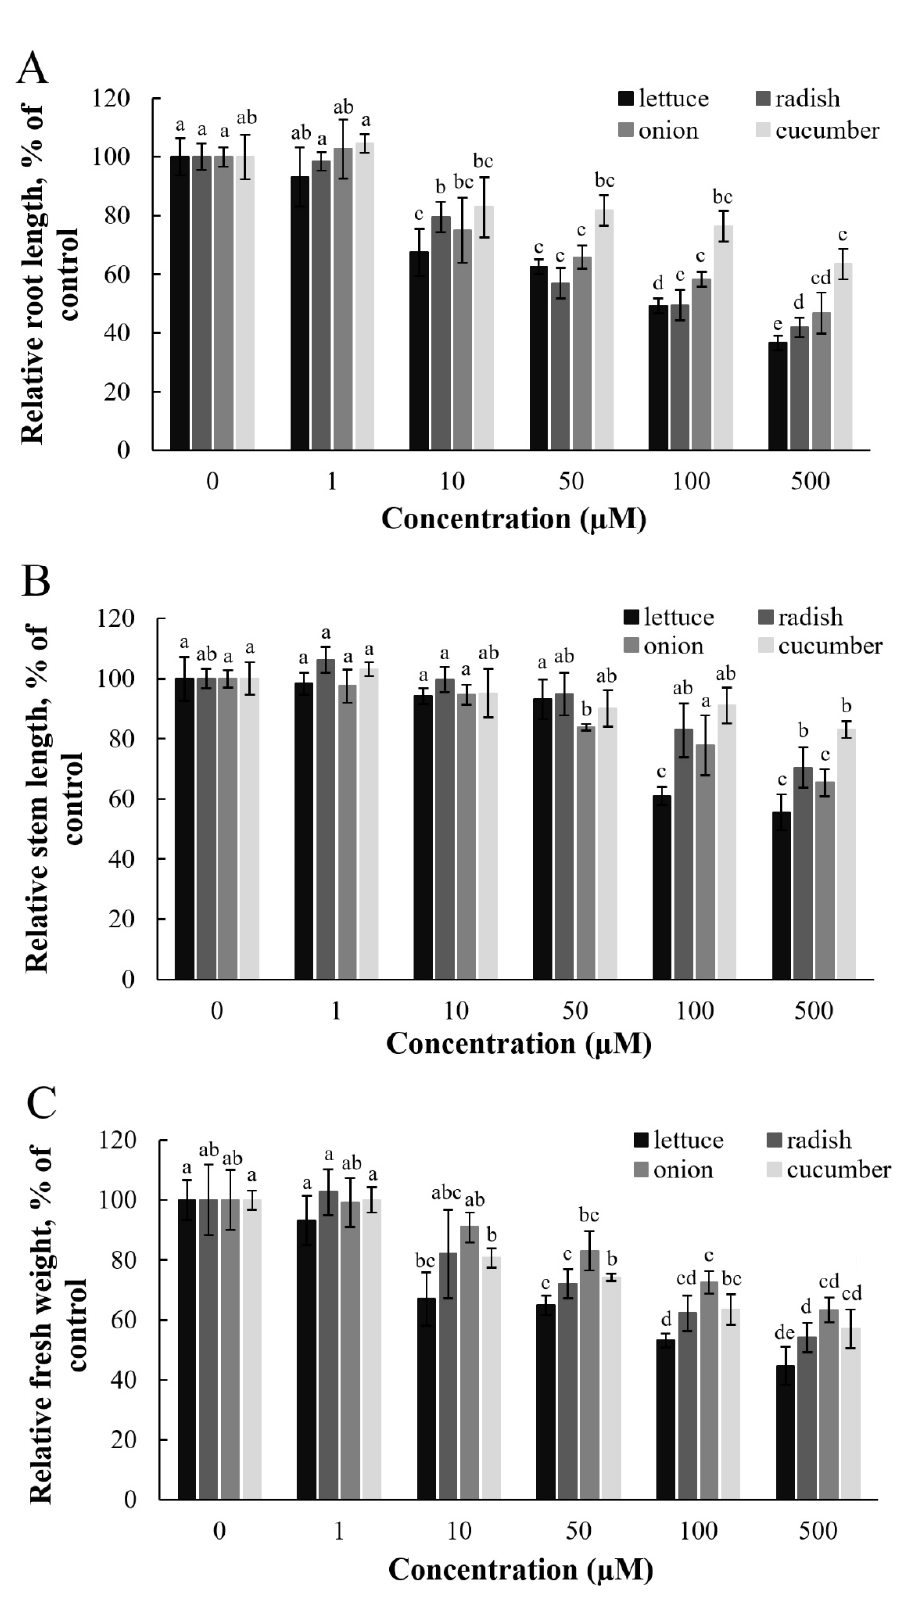
Figure 2. Seedling growth indices of root length ( A ), stem length ( B ) and fresh weight ( C ) of four vegetable seeds under treatments with acacetin. The results presented are mean of three replicates ± SE, different letters denote significant differences at p < 0.05 according to one-way ANOVA with an LSD test.